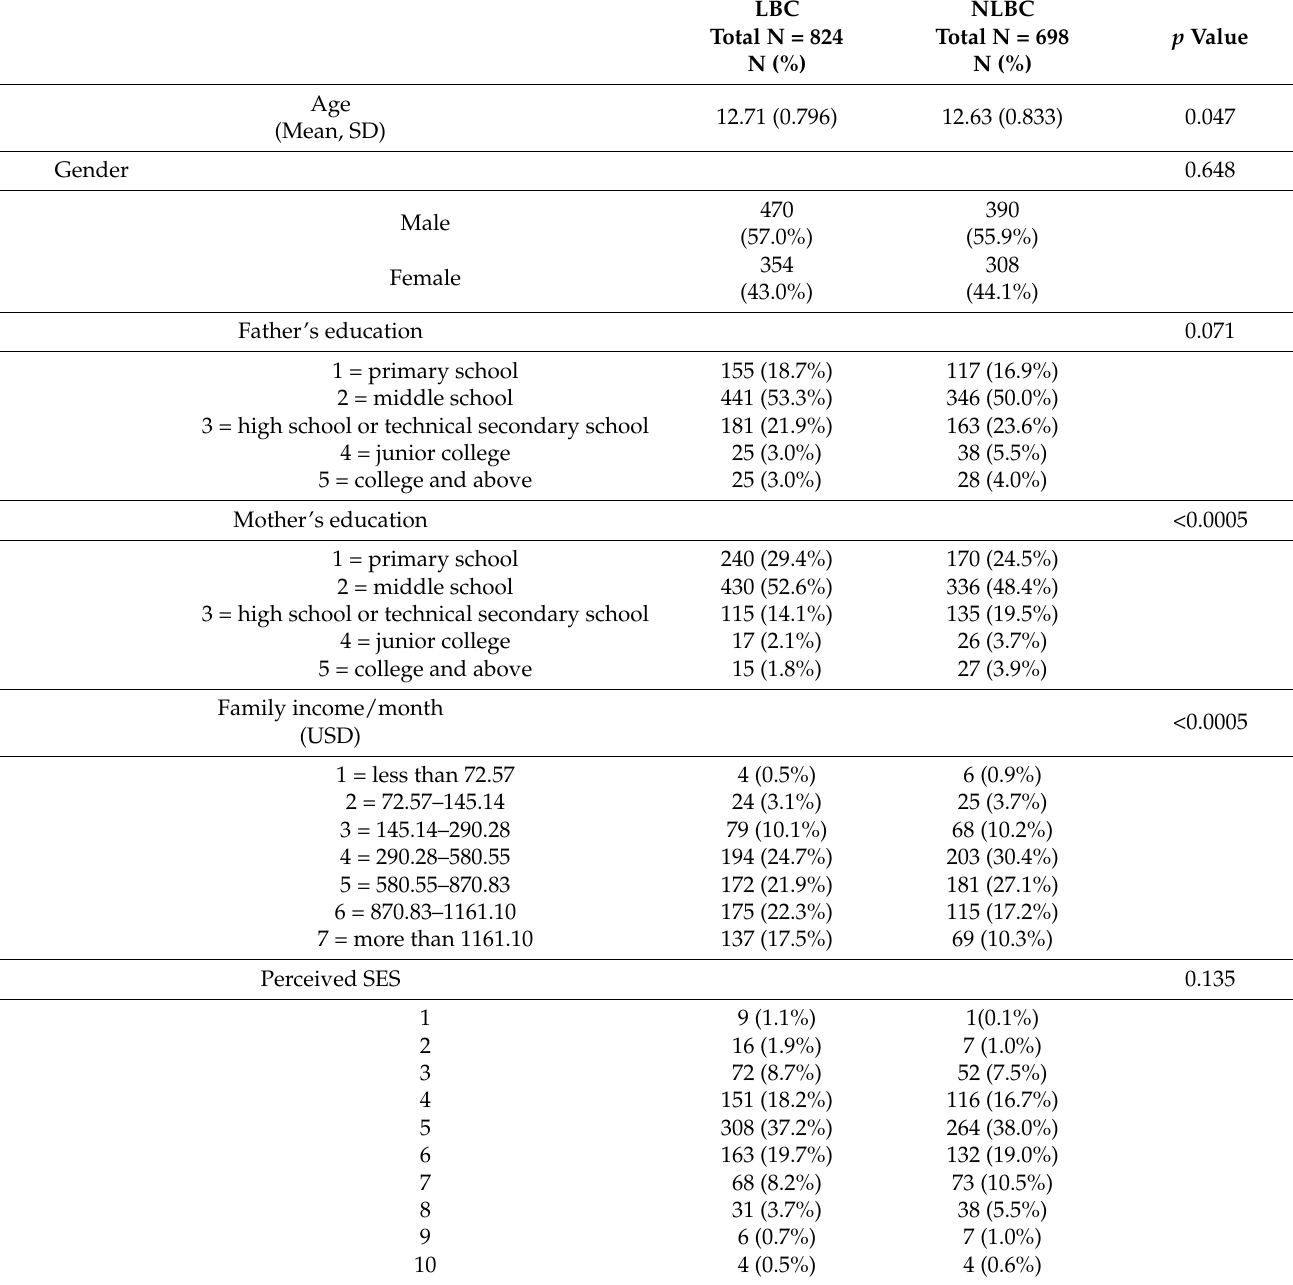
Table 1. Chi-square analysis on characteristics by parental migration